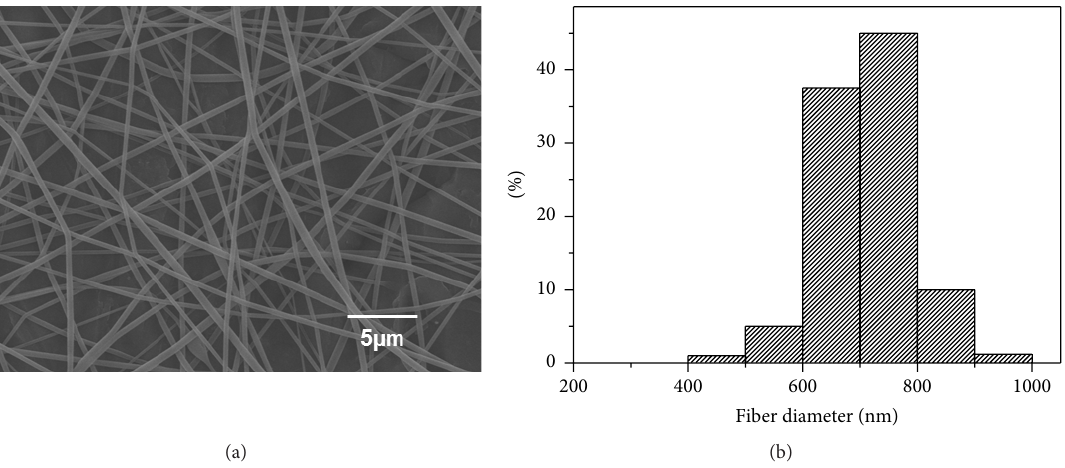
Figure 3: (a) SEM image and (b) diameter distribution of PEDOT:PSS/PVP nanofibers by conventional